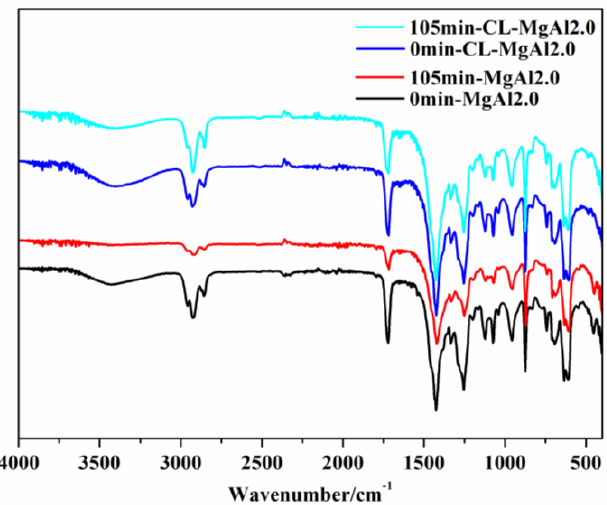
Figure 14. The ART-FTIR of PVC composites with MgAl2.0 and its crosslinked counterpart at aging times of 0 and 105 min.